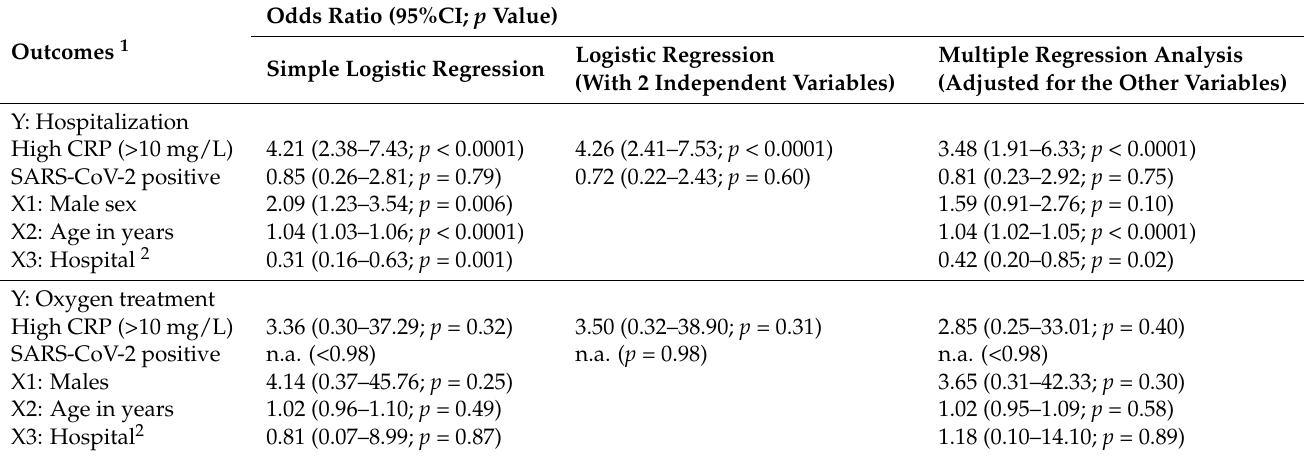
Table 2. Odds ratios (95% confidence intervals) and p values for the primary and secondary outcome in individuals with suspected COVID-19 (n = 1006).